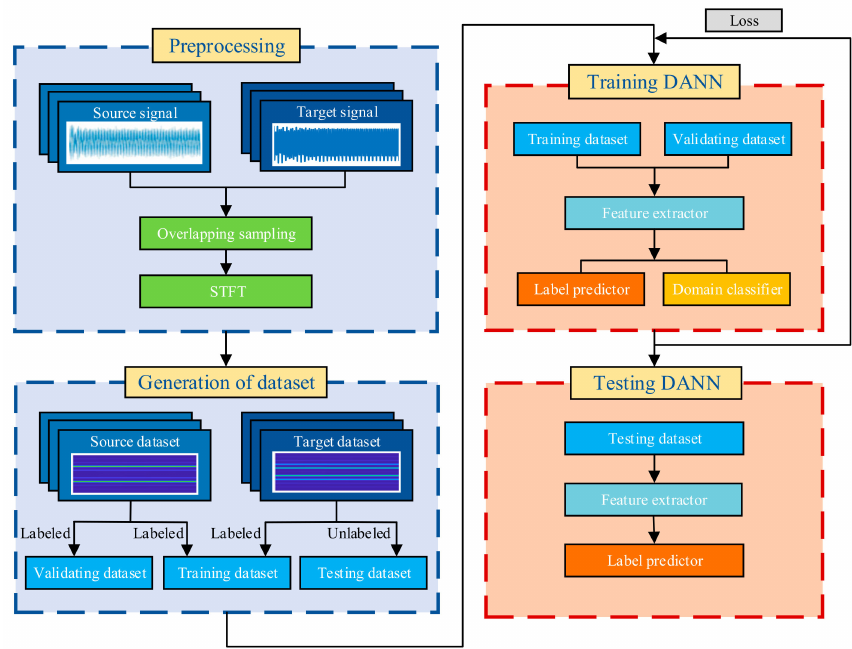
Figure 3. Diagnostic flow